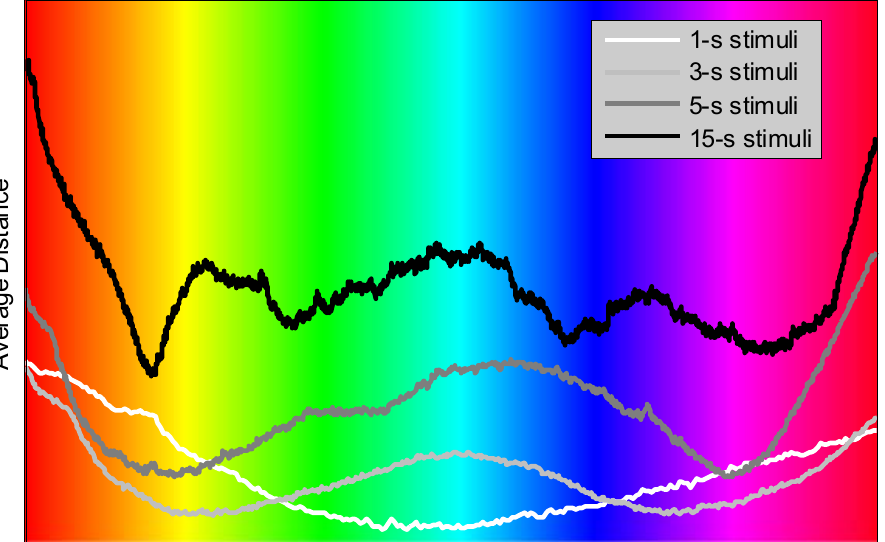
Figure 6. Distance averaged over 19 participants, 2 trials per participant, and all EEG channels as a function of stimulation color.